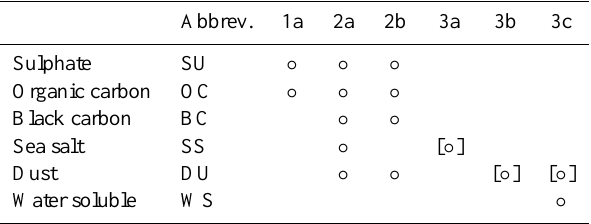
Table 2. The processes have been limited to certain size ranges. Coagulation of large particles is not considered due to low impor- tance. Dry deposition and sedimentation have very limited effect on the population in the smaller soluble size ranges. Nucleation creates new particles only in the smallest size section.